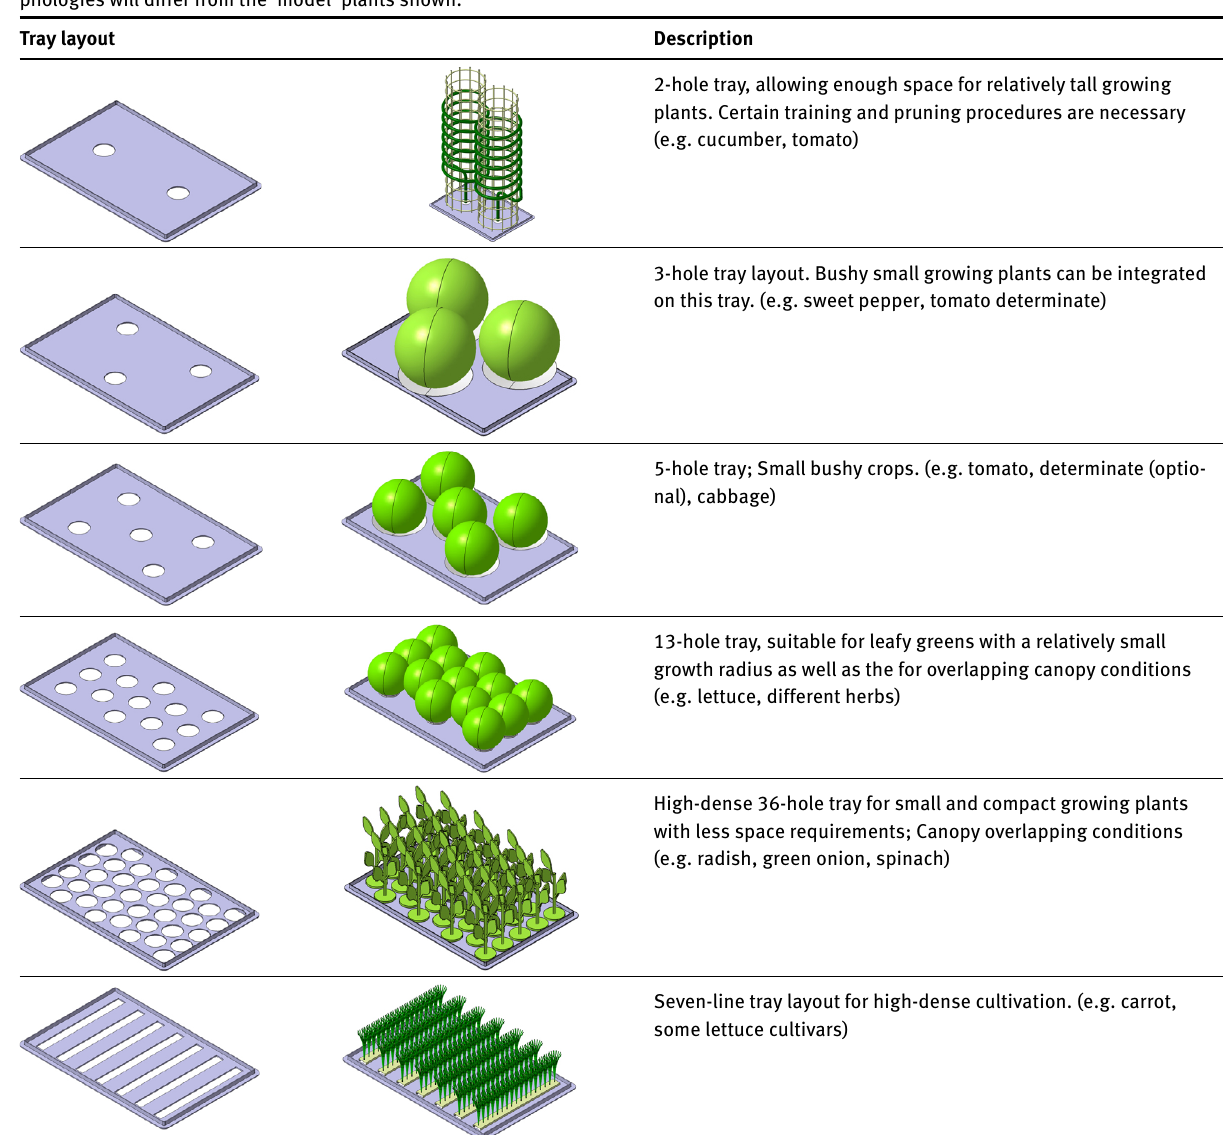
Table 1: Six different tray lids with different plant distribution patterns were designed to accommodate a range of crop types. The tray lids outline the maximal spacing for the plant positioning. The placed shoot zones are only for visualization purposes, since actual plant mor- phologies will differ from the ‘model’ plants